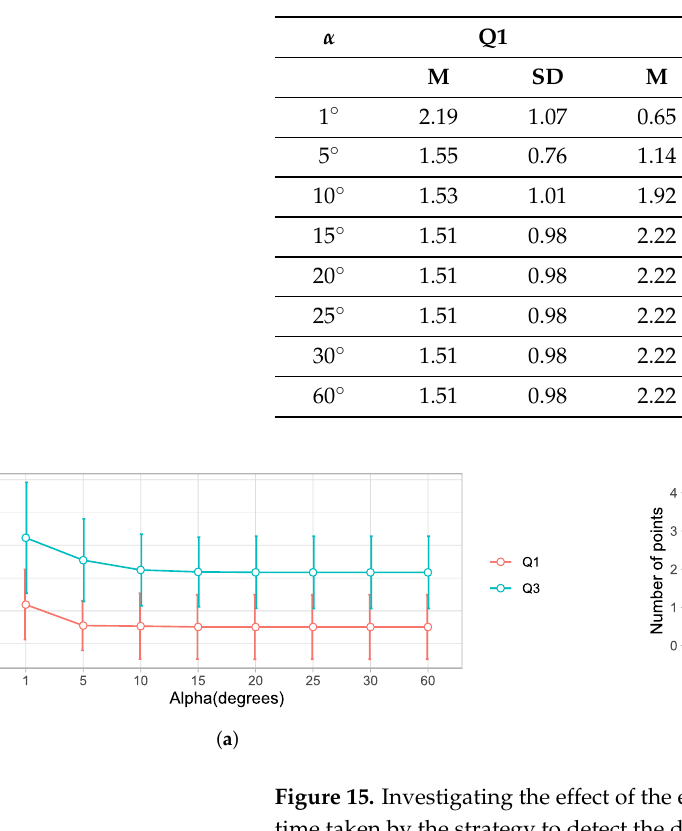
Table 4. Mean and standard deviation of Q1, Q2, Q3, and Q4 for different α .